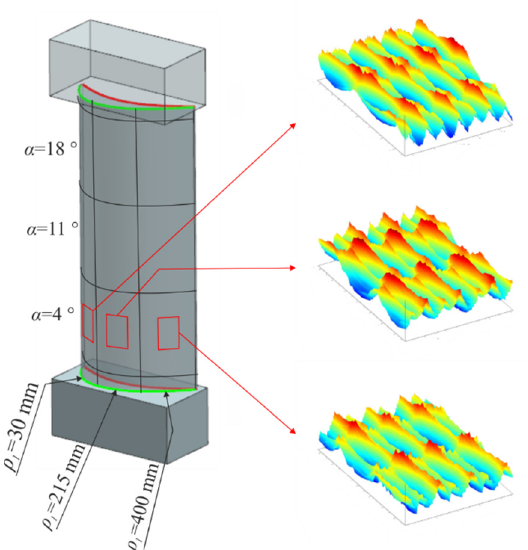
Figure 24. Topography of the convex surface when changing the curvature radius for the lead angle α = 4°.